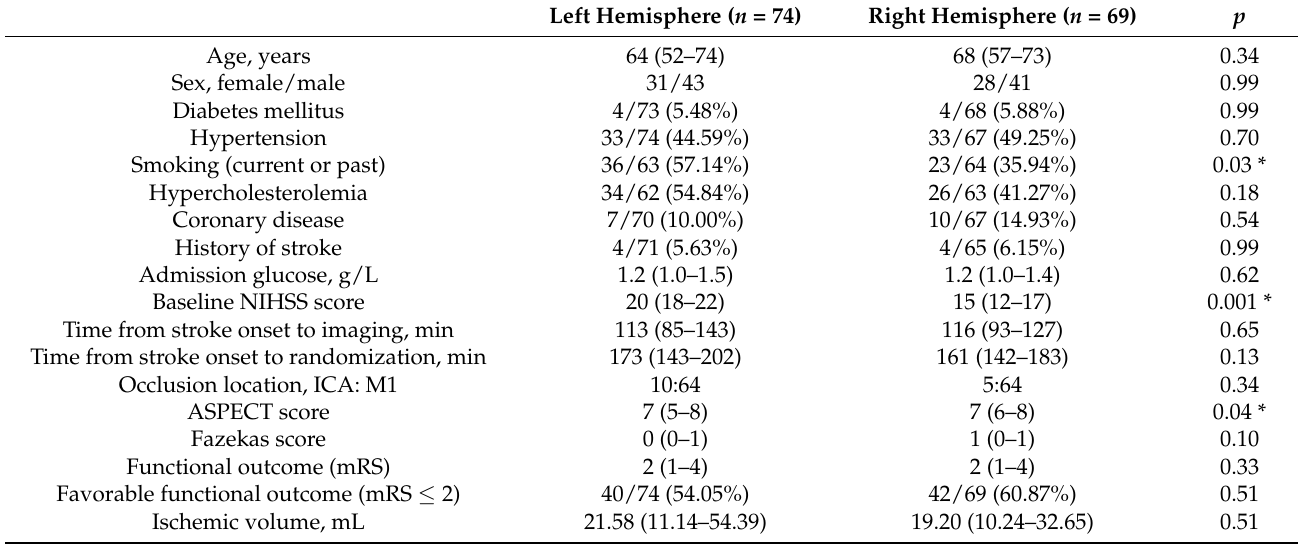
Table 1. Baseline characteristics and functional outcome of left- vs. right-hemisphere stroke patients.